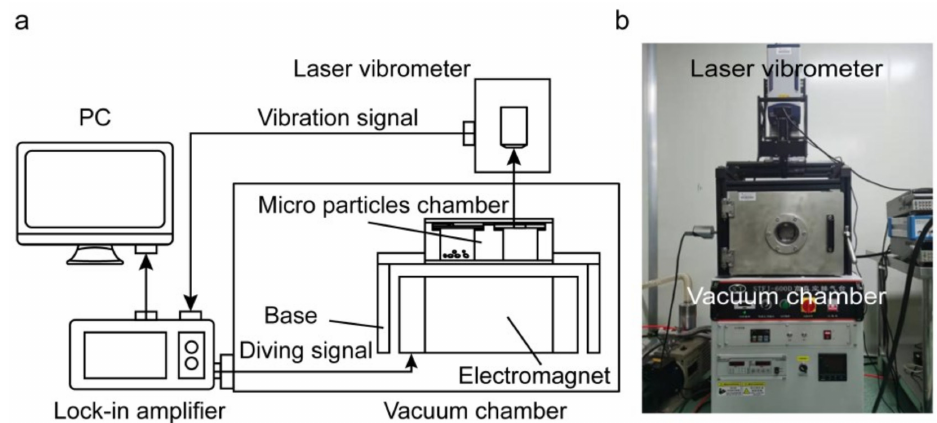
Figure 8. Method of laser vibration measurement. ( a ) Schematic diagram of principle; ( b ) Image of the laser vibration system.